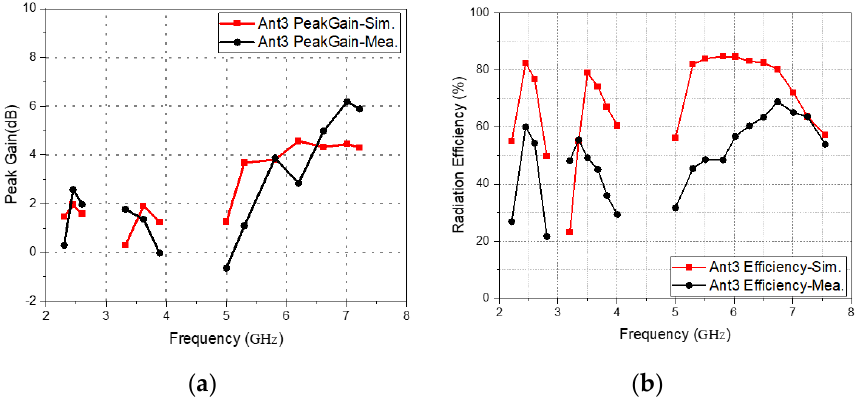
Figure 19. ( a ) Simulated and measured gain values of Ant. 3, ( b ) simulated and measured efficiency values of Ant. 3.